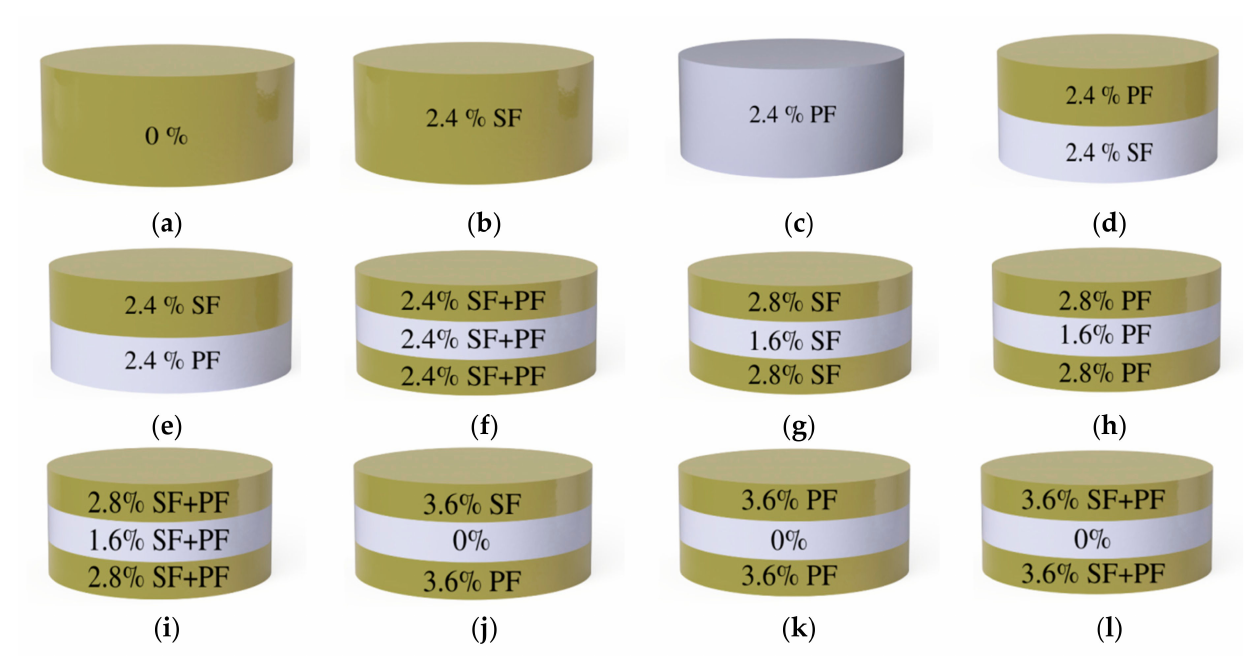
Figure 6. Details of fiber content used in the layers. ( a ) PAC, ( b ) S-SF, ( c ) S-PF, ( d ) D-SF-PF, ( e ) D-PF-SF, ( f ) T-FG1, ( g ) T-FG2, ( h ) T-FG3, ( i ) T-FG4, ( j ) T-FG5, ( k ) T-FG6, ( l )